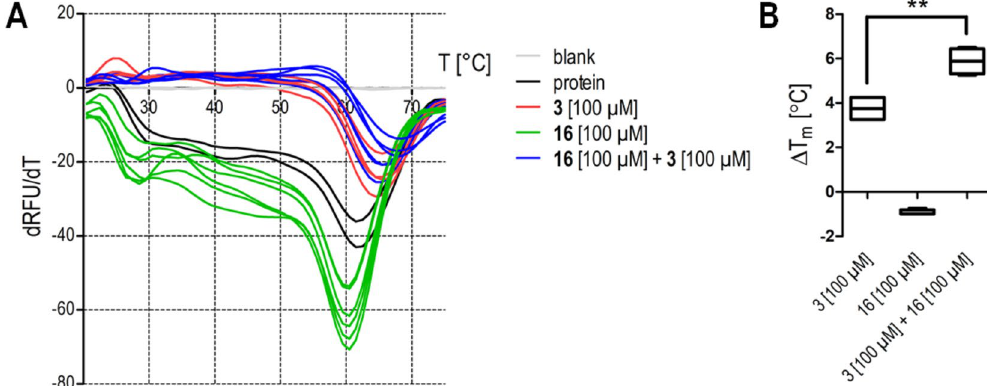
Figure 5. Interaction of 16 with FXR studied by thermal shift. ( A ) Melt curves of the FXR-LBD alone (black), in presence of FXR agonist 3 (red), in presence of 16 (green) and in presence of 3 and 16 together (blue). (SYPRO-Orange, n = 2–6). ( B ) FXR agonist 3 causes a significant thermal shift of the FXR-LBD melting point confirming binding. 16 alone induces a weak negative shift but significantly enhances the thermal shift caused by 3 confirming further FXR-LBD stabilization and a direct